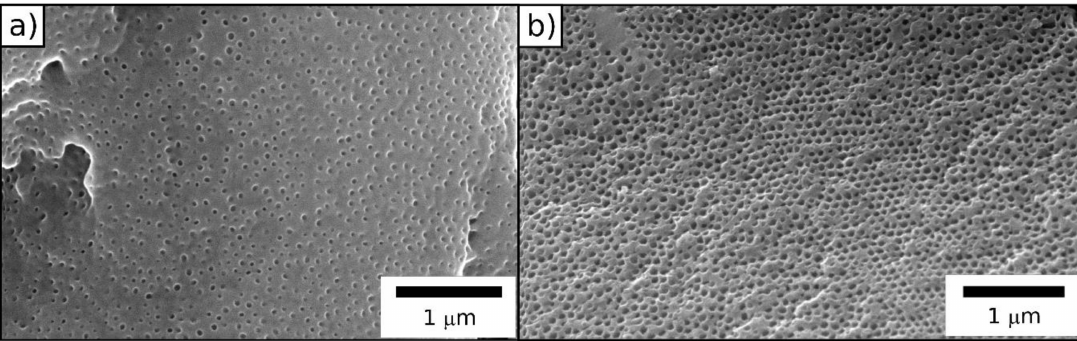
Figure 7. SEM photographs of the ( a ) surface and ( b ) cross-section of a porous SiCN film after melt-shearing and ceramization of core / shell particles processed by emulsion polymerization and FRP. SEM images (Figure 7) indicate the successful preparation of an ordered porous